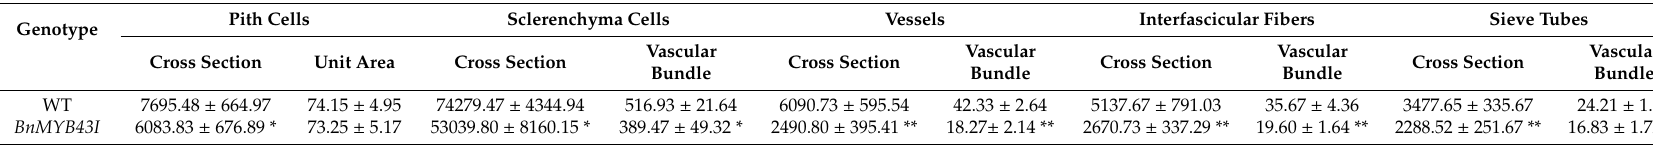
Table 1. Number of cells of pith, sclerenchyma, vessels, interfascicular fibers and sieve tubes of stems of BnMYB43I transgenic